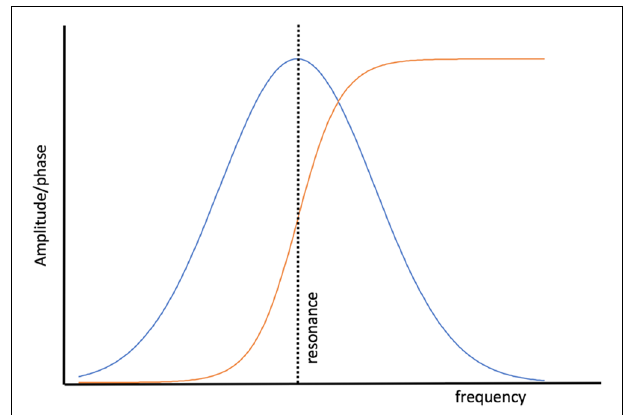
FIGURE 2 | The behavior of a simple, undamped oscillator as a function of the excitation frequency. The amplitude of the response of the oscillator (blue) to the driving force peaks when the driver reaches the natural resonance of the oscillator. The phase of the oscillator with respect to the driver (orange) is in a phase when the driving frequency is lower than the resonant frequency and anti-phase when the driving frequency exceeds resonance.